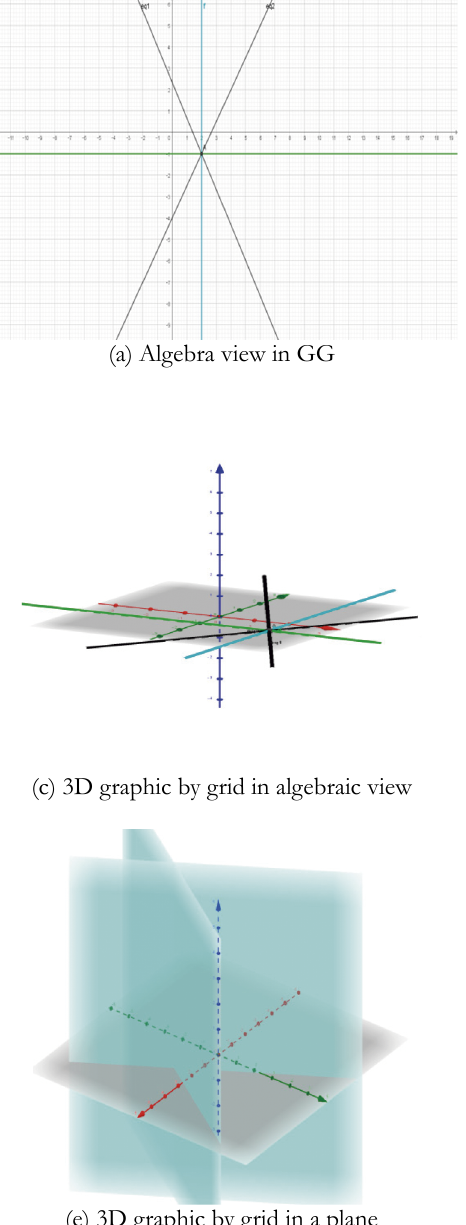
Figure 1. Students’ engagement with